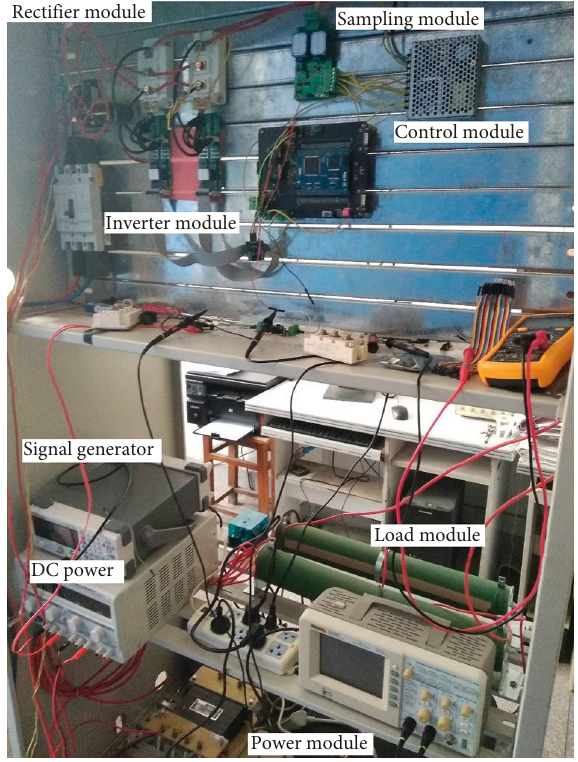
Figure 24: DVR experimental system platform.